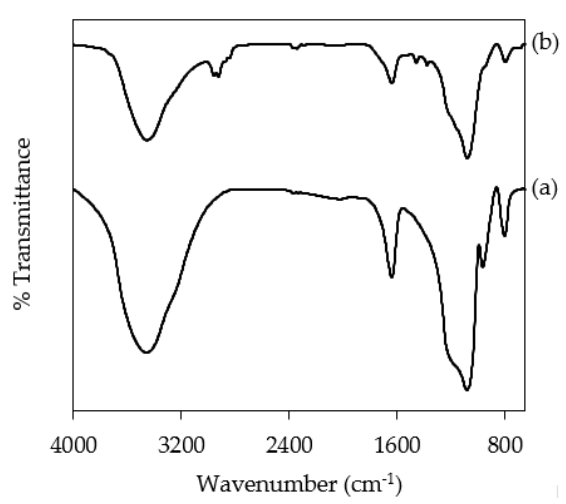
Figure 2. XRD pattern of NH 2 KIT-6.